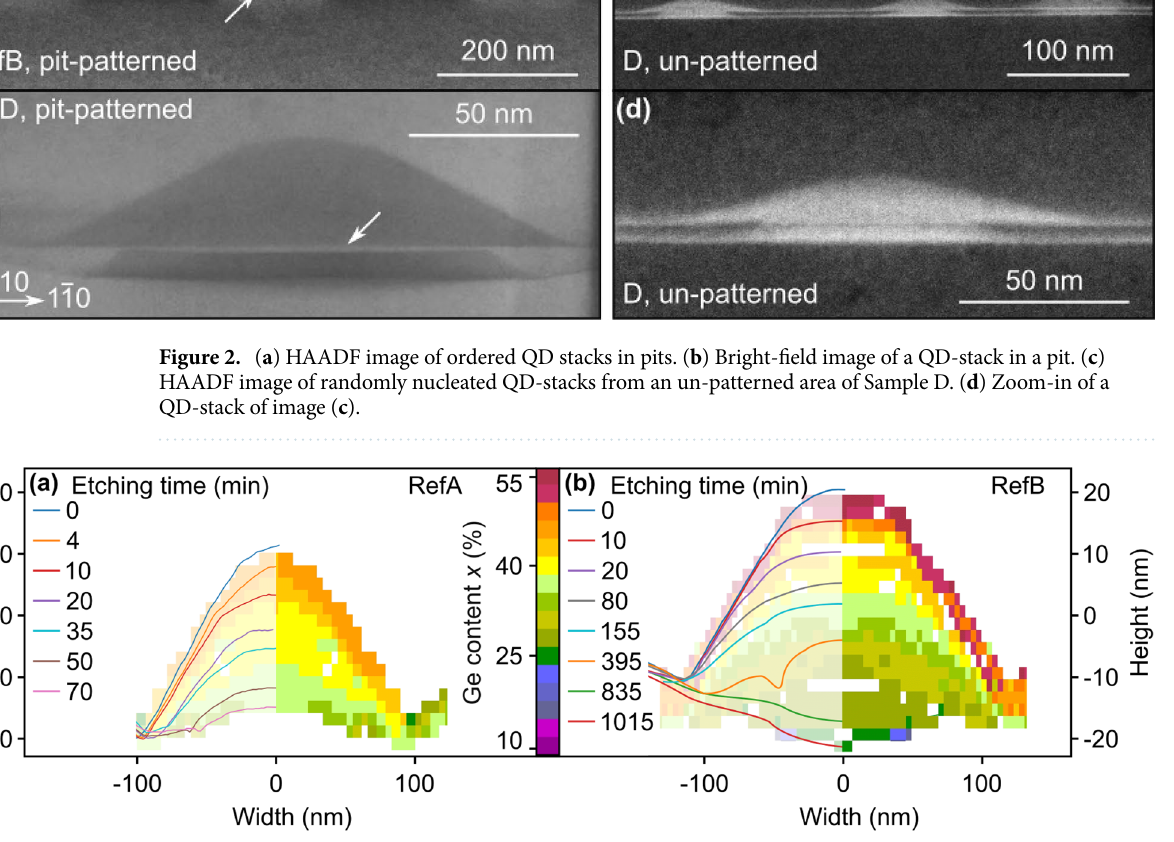
Figure 3. ( a ), ( b ) Nanotomography of samples RefA and RefB. The solid lines represent AFM line scans recorded after etching in NHH solution (see “Methods” section) for different etching times from 0 to 1015 min. The origin of the ordinate corresponds to the position of the (001) surface between the QDs. The underlying color-coded map shows the Ge-content which was extracted with the composition-dependent etching rate of the employed NHH solution. The negative half-space of the color map is a mirrored copy of the positive